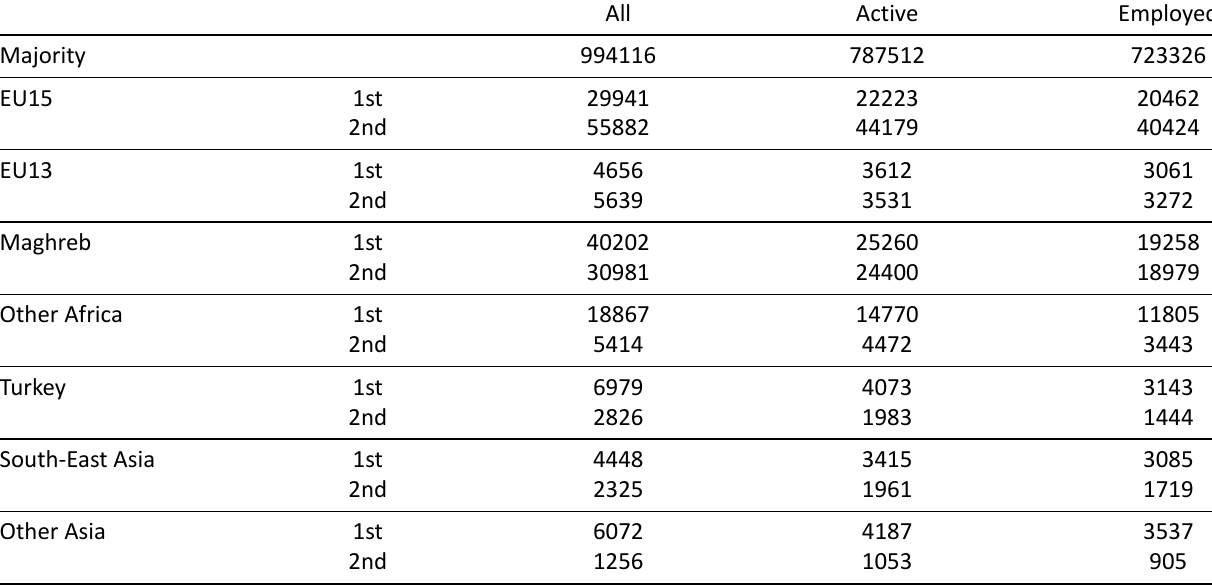
Table A1. Sample sizes by origin groups and by generation (N). Source: INSEE Labour Force Survey 2013–2017, excluding people in education or in training.